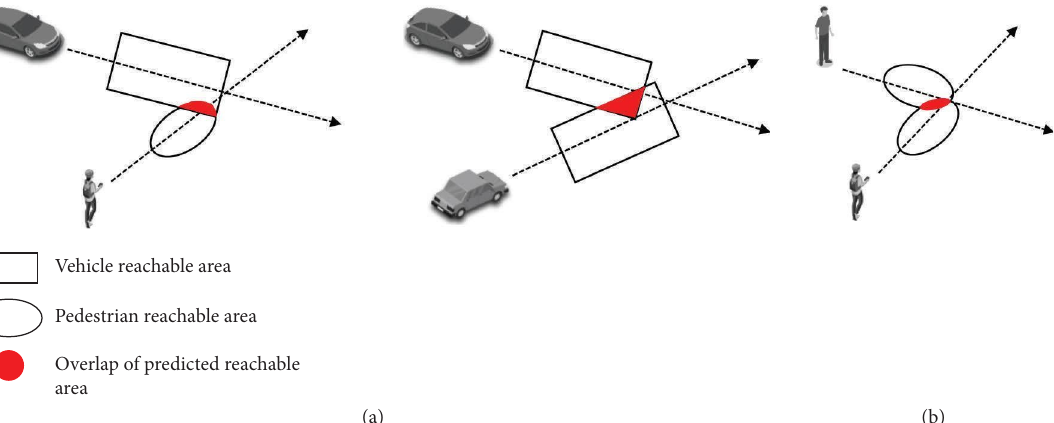
Figure 5: Collision risk defnition of the proposed system. Te system detects collision risks of pedestrian-to-vehicle and vehicle-to-vehicle as in (a), whereas the system does not account for pedestrian-to-pedestrian collision risks as in (b).